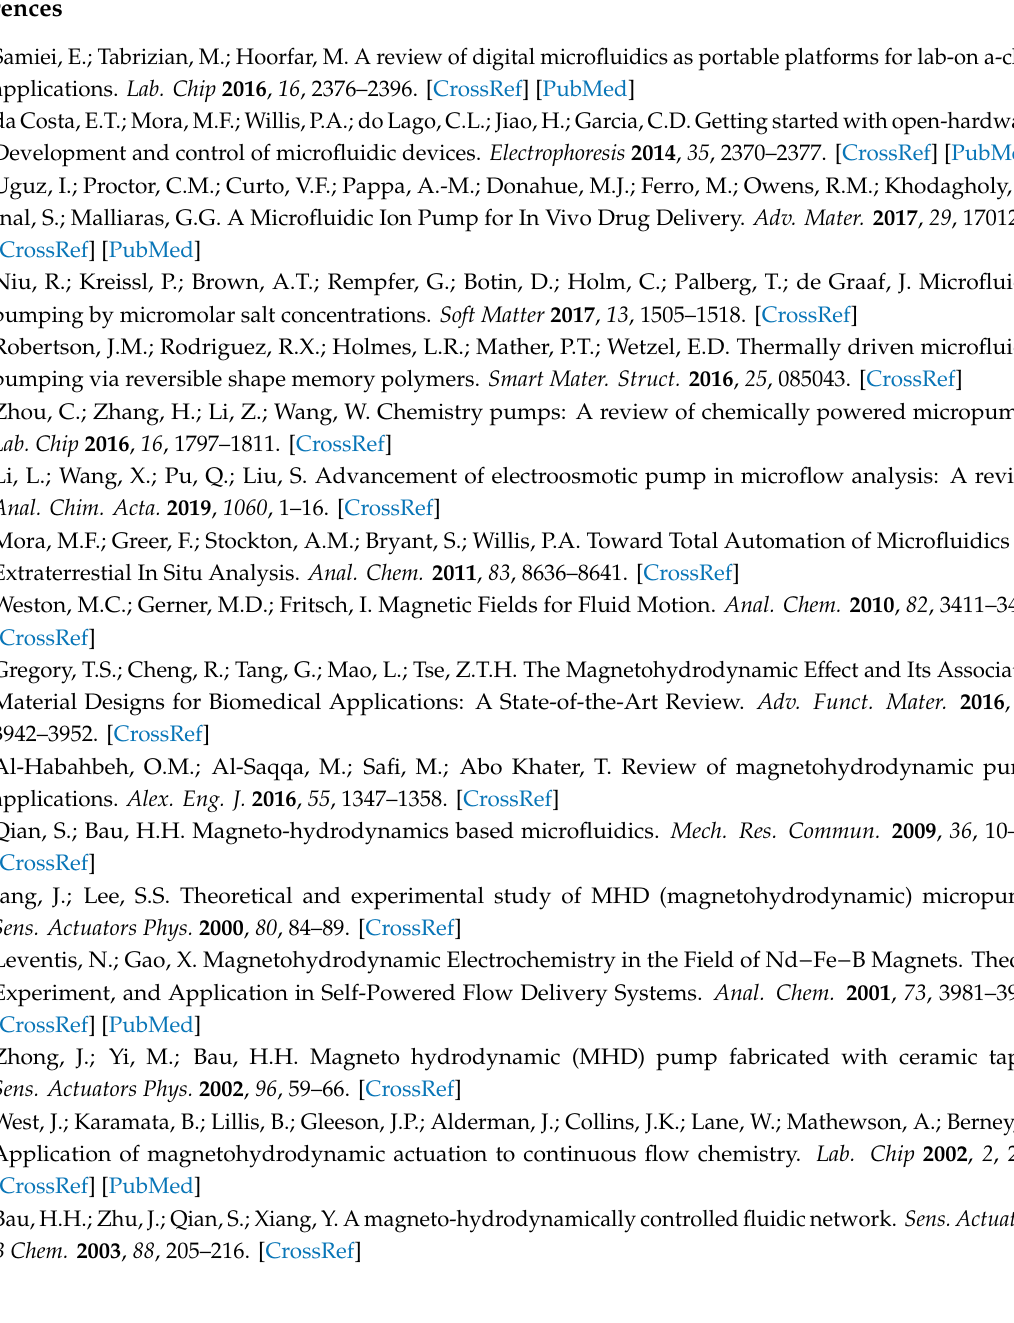
the USB digital microscope, using ImageJ ® software, showing the RGB detection at the T-junction chip. Figure S4: Picture of the multi-pump apparatus used for methylene blue injections and D-glucose assay kit. Video S1: Capture of a sequence of dye injections, followed by the rinsing